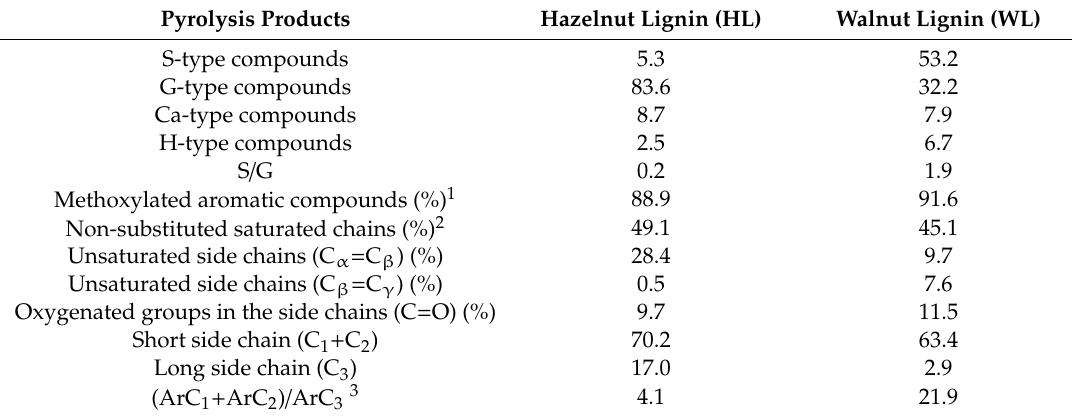
Table 2. Relative content (%) of phenolic-type compounds and their classification according to their structural characteristics.